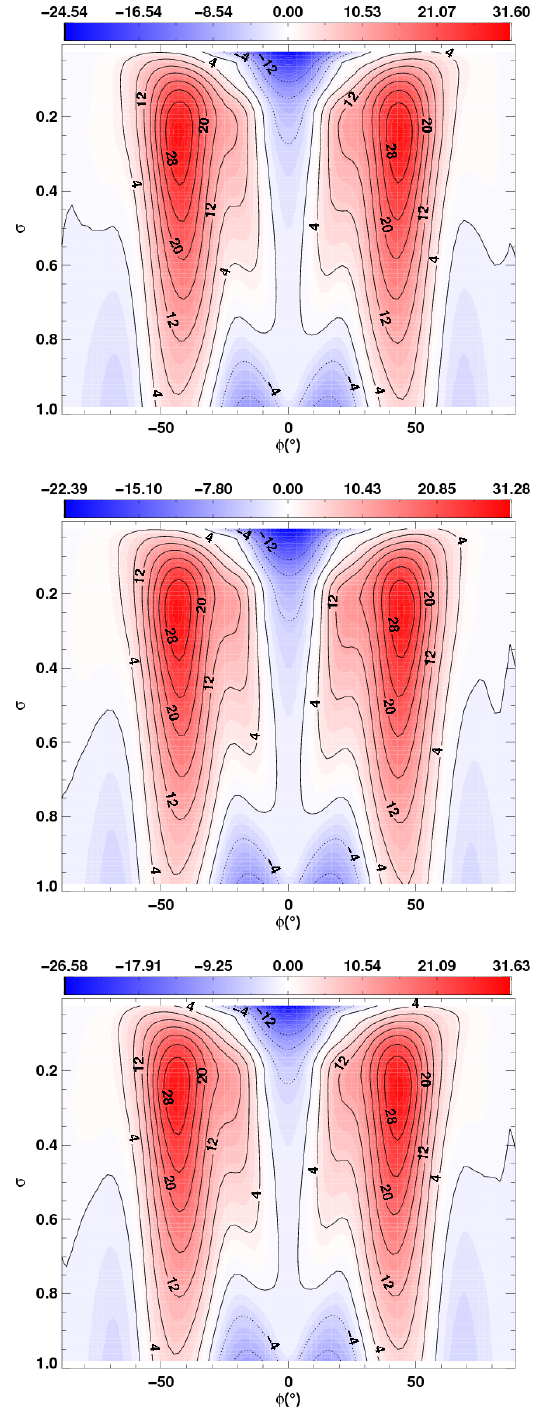
Figure 4. Figure, for the Held–Suarez test (Held and Suarez, 1994), showing the zonally and temporally averaged zonal wind (ms − 1 ) Fig. 4. Figure, for the Held–Suarez test (Held and Suarez, 1994), as a function of latitude and σ . Top panel: EG model (also shown in showing the zonally and temporally averaged zonal wind (ms − 1 ) Fig. 3 but reproduced here to aid comparison). Middle panel: EG gc as a function of latitude and σ . Top panel: EG model (also shown model. Bottom panel: EG sh model (see Table 2 for explanation of in Figure 3 but reproduced here to aid comparison). Middle panel: model EG gc model. Bottom panel: EG sh model (see Table 2 for explana- tion of model types).